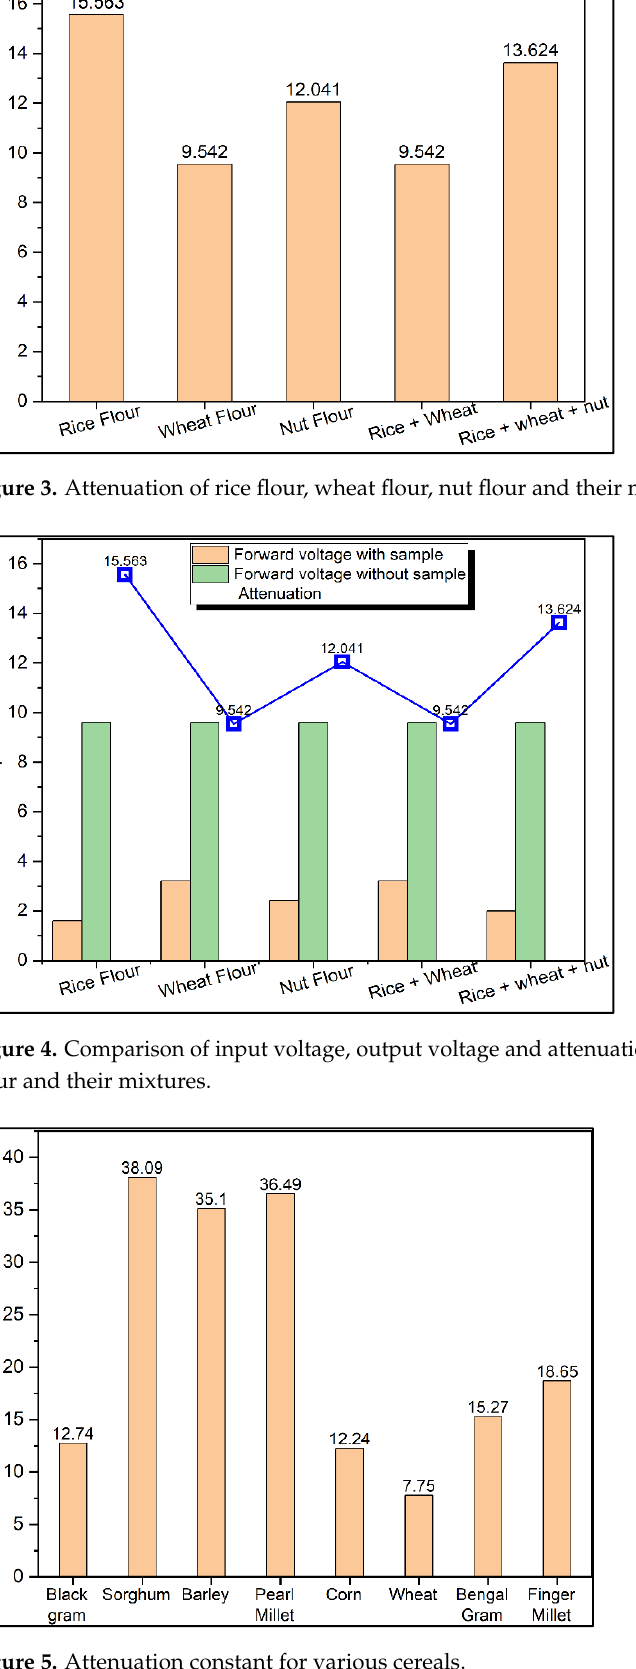
Figure 5. Attenuation constant for various cereals.